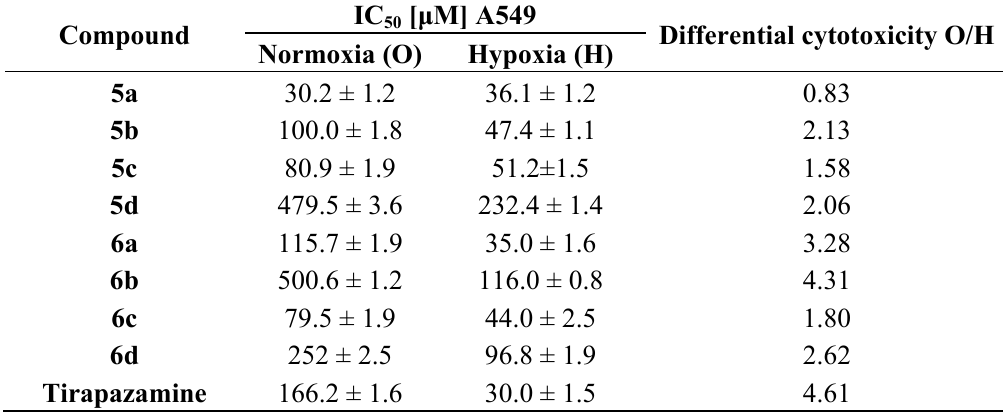
Table 4. In vitro growth inhibition of selected tumor cell lines by new benzimidazole-4, 7-dione derivatives. [ μ M] A549 IC 50 Differential cytotoxicity O/H Compound Normoxia